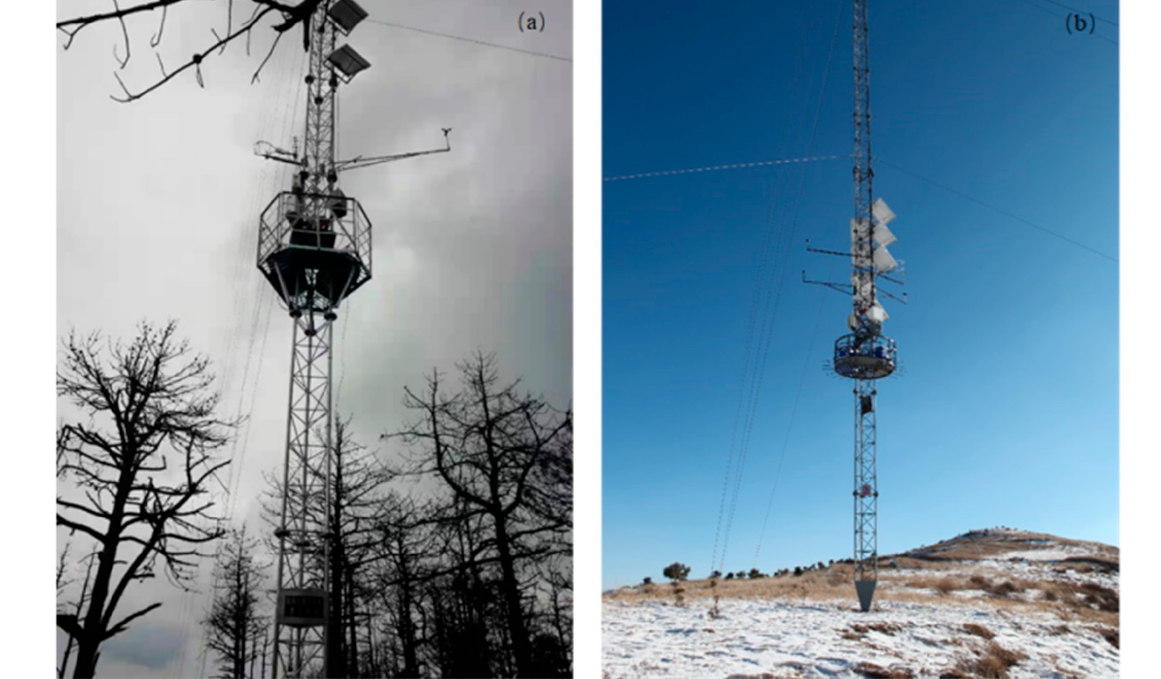
Figure 1. Eddy covariance observation system at ( a ) site 1 and ( b ) site 2.